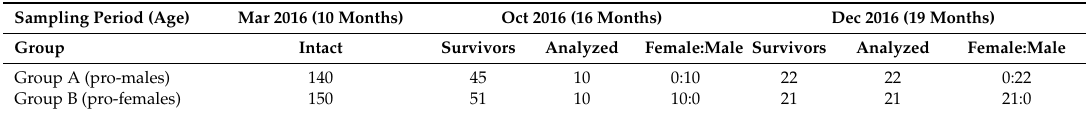
Table 1. Changes of sex ratio from one to two years of age in the Yesso scallop. Sampling Period